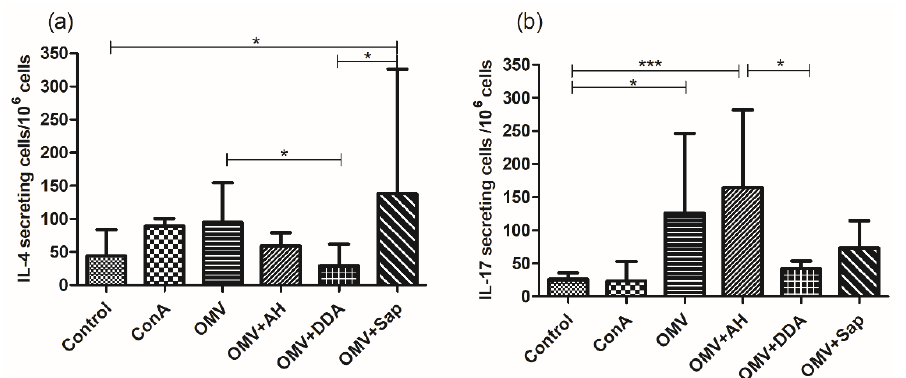
Figure 7. Cytokine analysis by ELISpot, when mice were 18 months old. The production of ( a ) IL-4 and ( b ) IL-17 by splenocytes were compared between the groups. For statistical analysis, it was used the Kruskal–Wallis test followed by Dunn’s post-hoc test. * p < 0.05 and *** p < 0.001. AH: aluminium hydroxide; DDA: dimethyldioctadecylammonium bromide; OMV: outer membrane vesicles; Sap: Saponin.